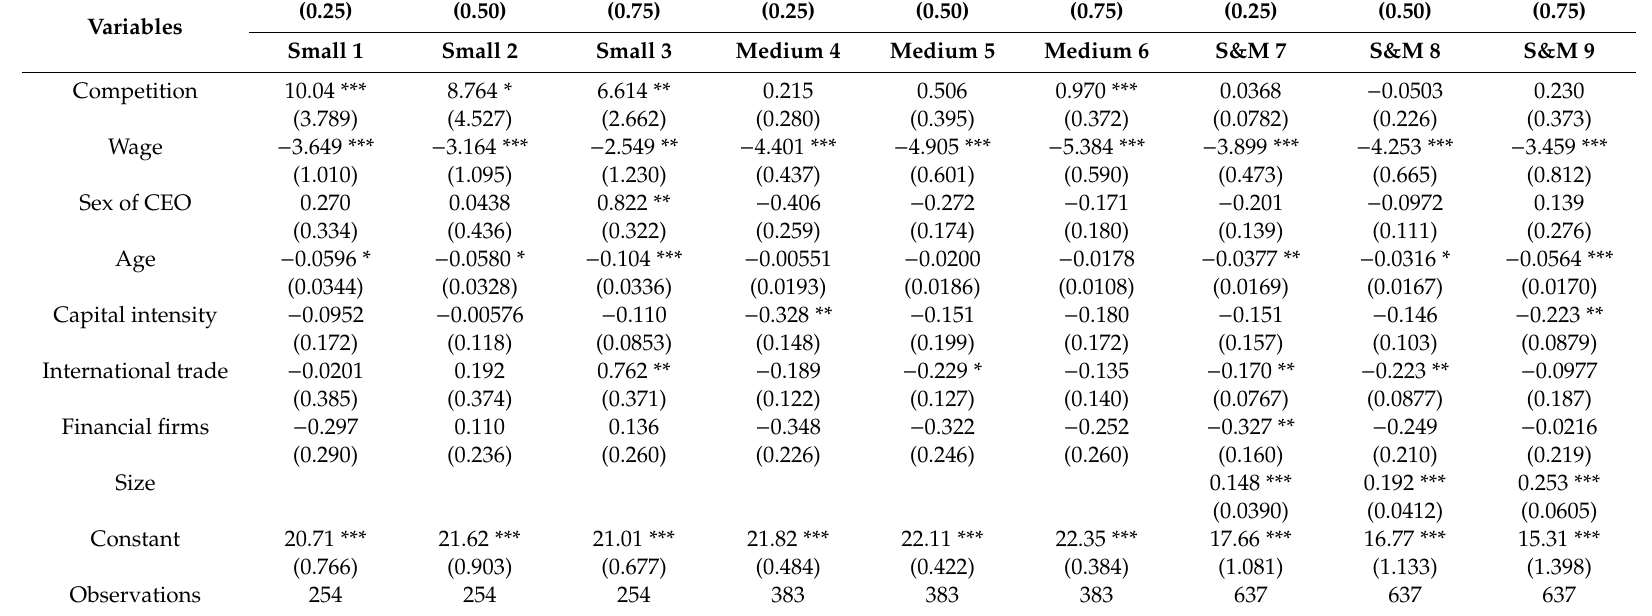
Table 6. Quantile regression results by firms’